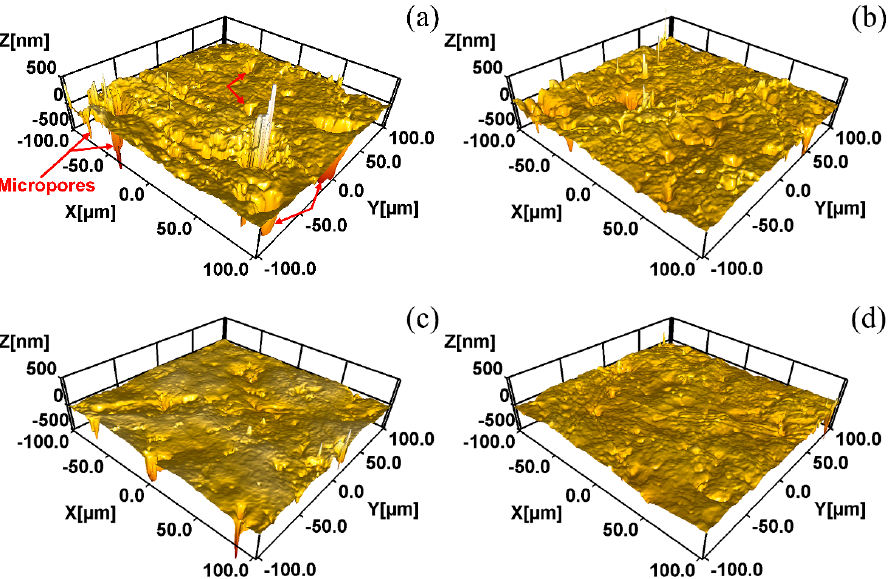
Figure 2. Coating surface morphologies of specimens from 3D white-light interfering surface profiler: ( a ) ZC; ( b ) ZFC; ( c ) PZC; ( d ) PZFC.